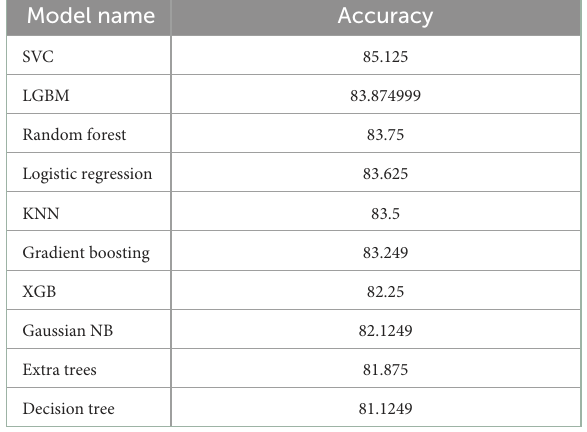
TABLE 2 Accuracy of each algorithms used.